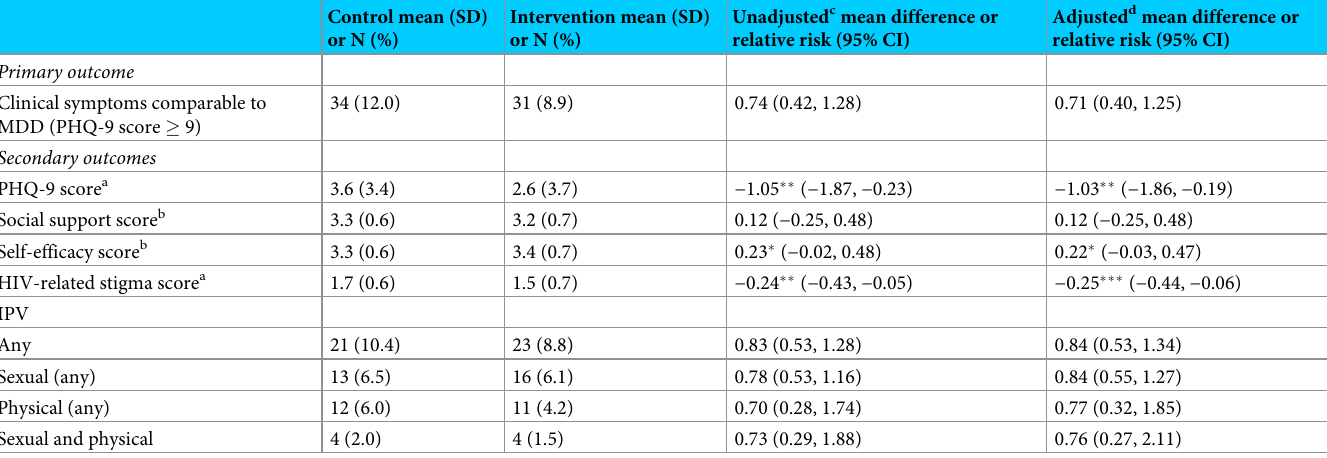
Table 2. Effect of the intervention on primary and secondary outcomes at second follow-up, approximately 9 months